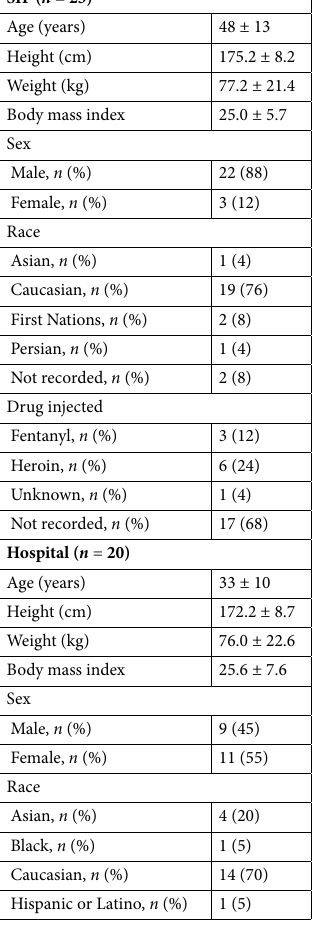
Table 1. Demographic summary of participants used for algorithmic evaluation of overdose detection and breathing rate